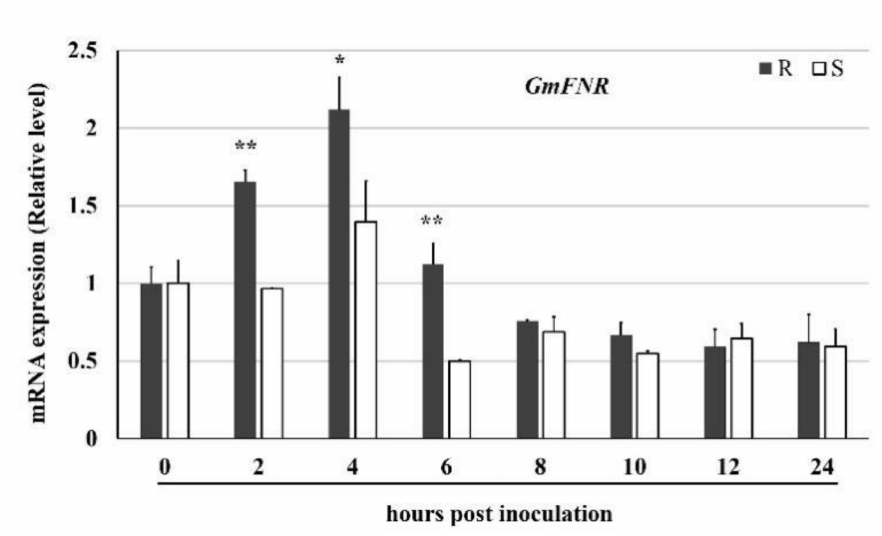
Figure 1. The expression profile of GmFNR in resistant (R) and susceptible (S) lines after soybean mosaic virus infection at 0–24 h post inoculation (hpi). Y-axes indicate the ratios of relative fold expression levels between samples infected with soybean mosaic virus. “*” and “**” indicate the statistical significance at p < 0.05 and p < 0.01, t- test. Error bars indicate SD ( n =